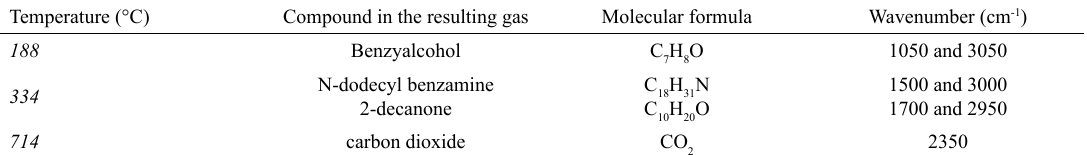
Table 1. Compounds present in the resulting gas at each thermal event of the thermal analysis of the epoxy resin.